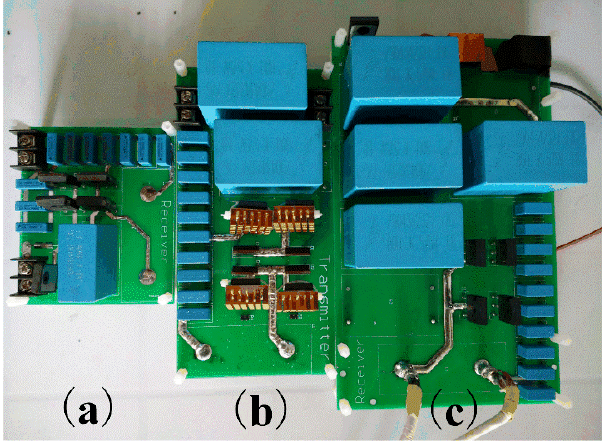
Figure 23. Receiver board with the 30 μ F ( a ), 160 μ F ( b ) and 320 μ F ( c ) filter